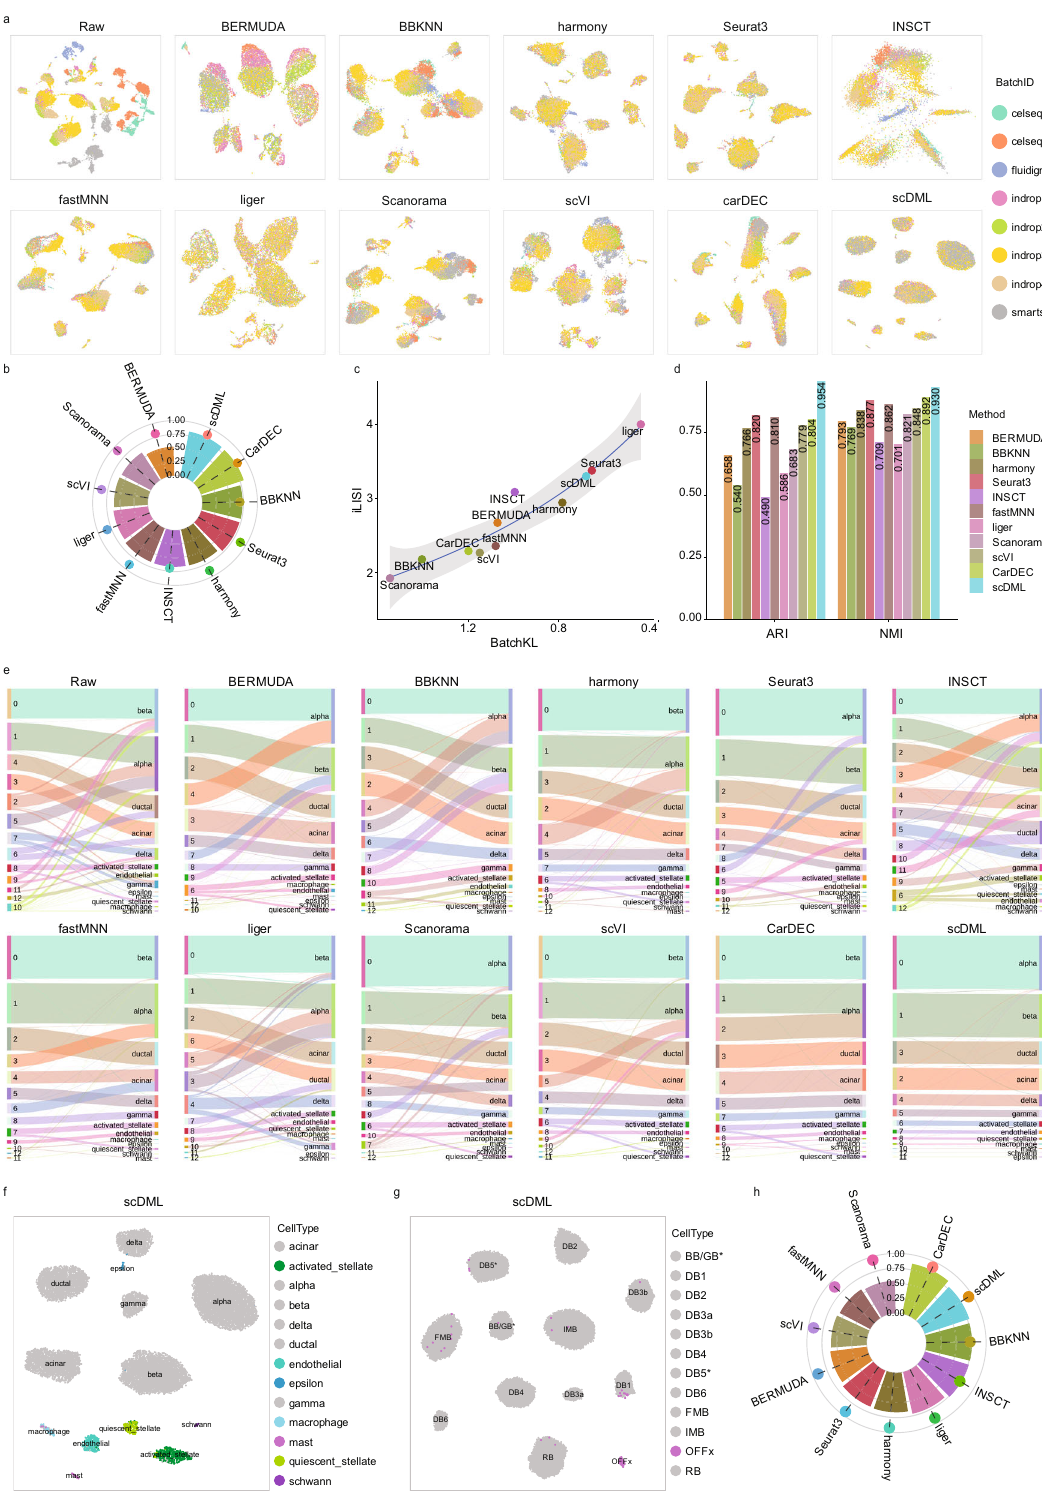
excluded Seurat 3, CarDEC and BERMUDA as the